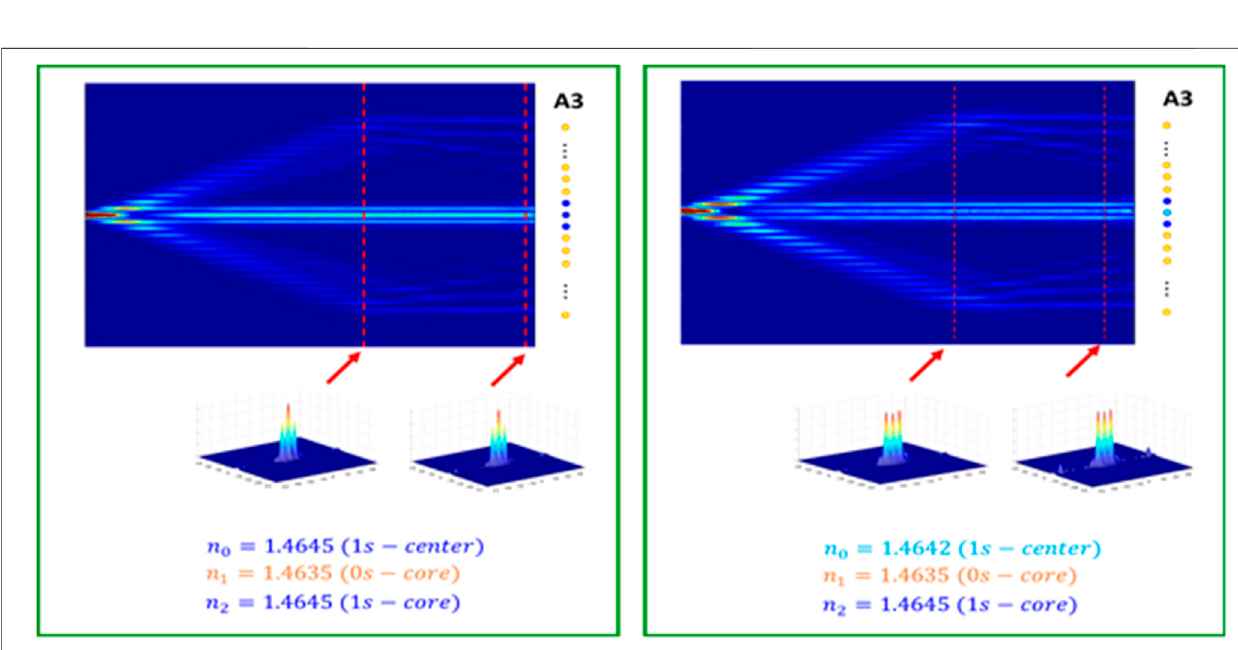
Frontiers in Physics |